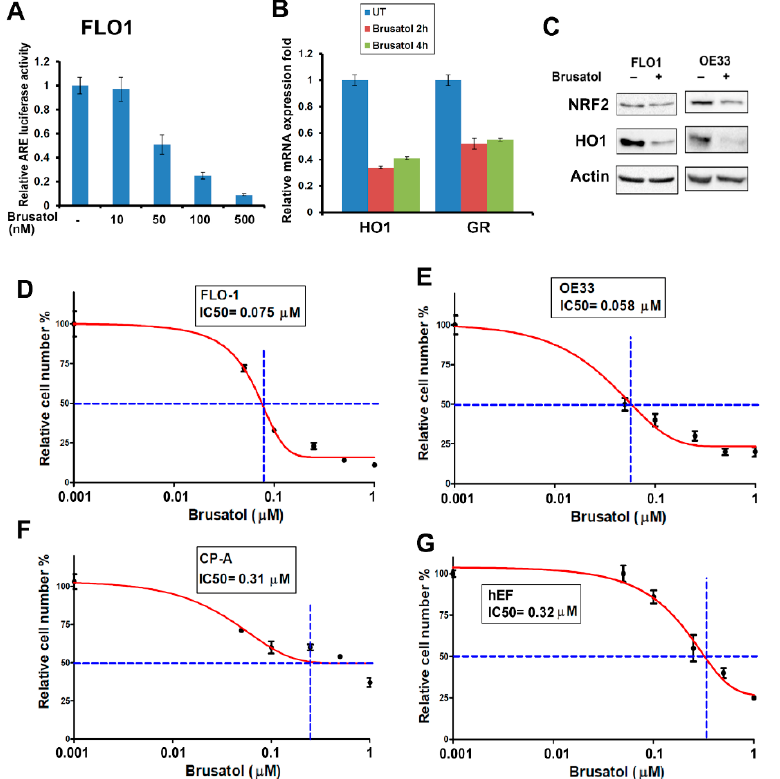
Figure 4. Brusatol inhibited NRF2 activity and killed EAC cells at low concentrations. ( A ) The ARE (antioxidant response element) luciferase reporter assay indicates the inhibition of NRF2 ARE activity at a 50–100 nM concentration of Brusatol. ( B ) Real-time RT-PCR shows the downregulation of NRF2 downstream target genes, HO1 and GR after Brusatol treatment. ( C ) Western blot displays the downregulation of the HO1 protein level after Brusatol treatment in the EAC cells. ( D – G ) The CellTiter Glo cell viability assay indicates that EAC cells were sensitive to Brusatol treatment with an IC50 below 100 nM ( D , E ), whereas the Barrett’s esophagus cells ( F ) and normal esophageal fibroblast cells ( G ) were more resistant to Brusatol treatment. The blue dot lines in D-G indicate the crosspoints between the 50% survival line and the dose-response curve.